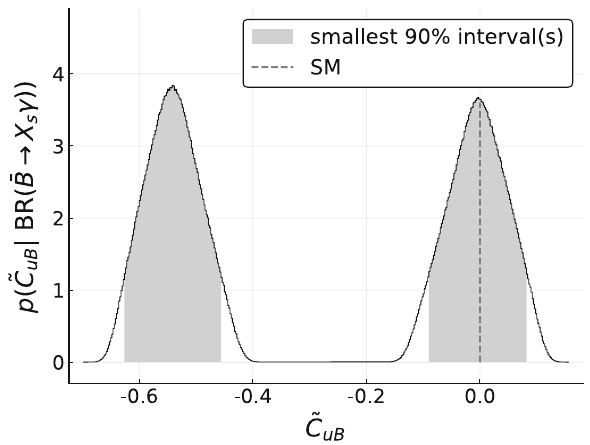
Fig. 8 Marginalized posterior probability distribution of ˜ C uB from the fit of all three Wilson coefficients to BR( ¯ B → X s γ ) only. The smallest interval containing 90% of the posterior probability and the SM value (dashed line) are